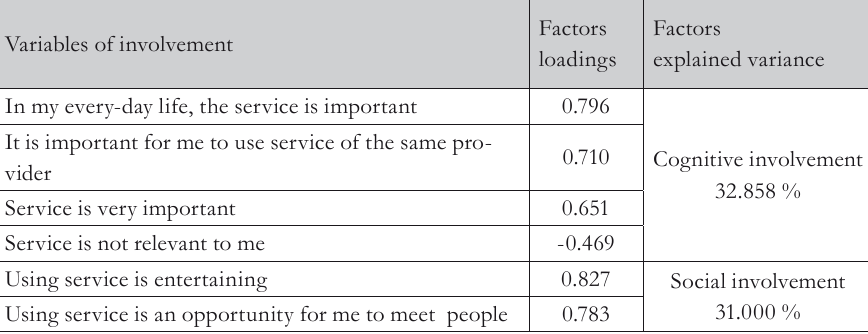
Tab. 1 – Factors of involvement Source: own compilation